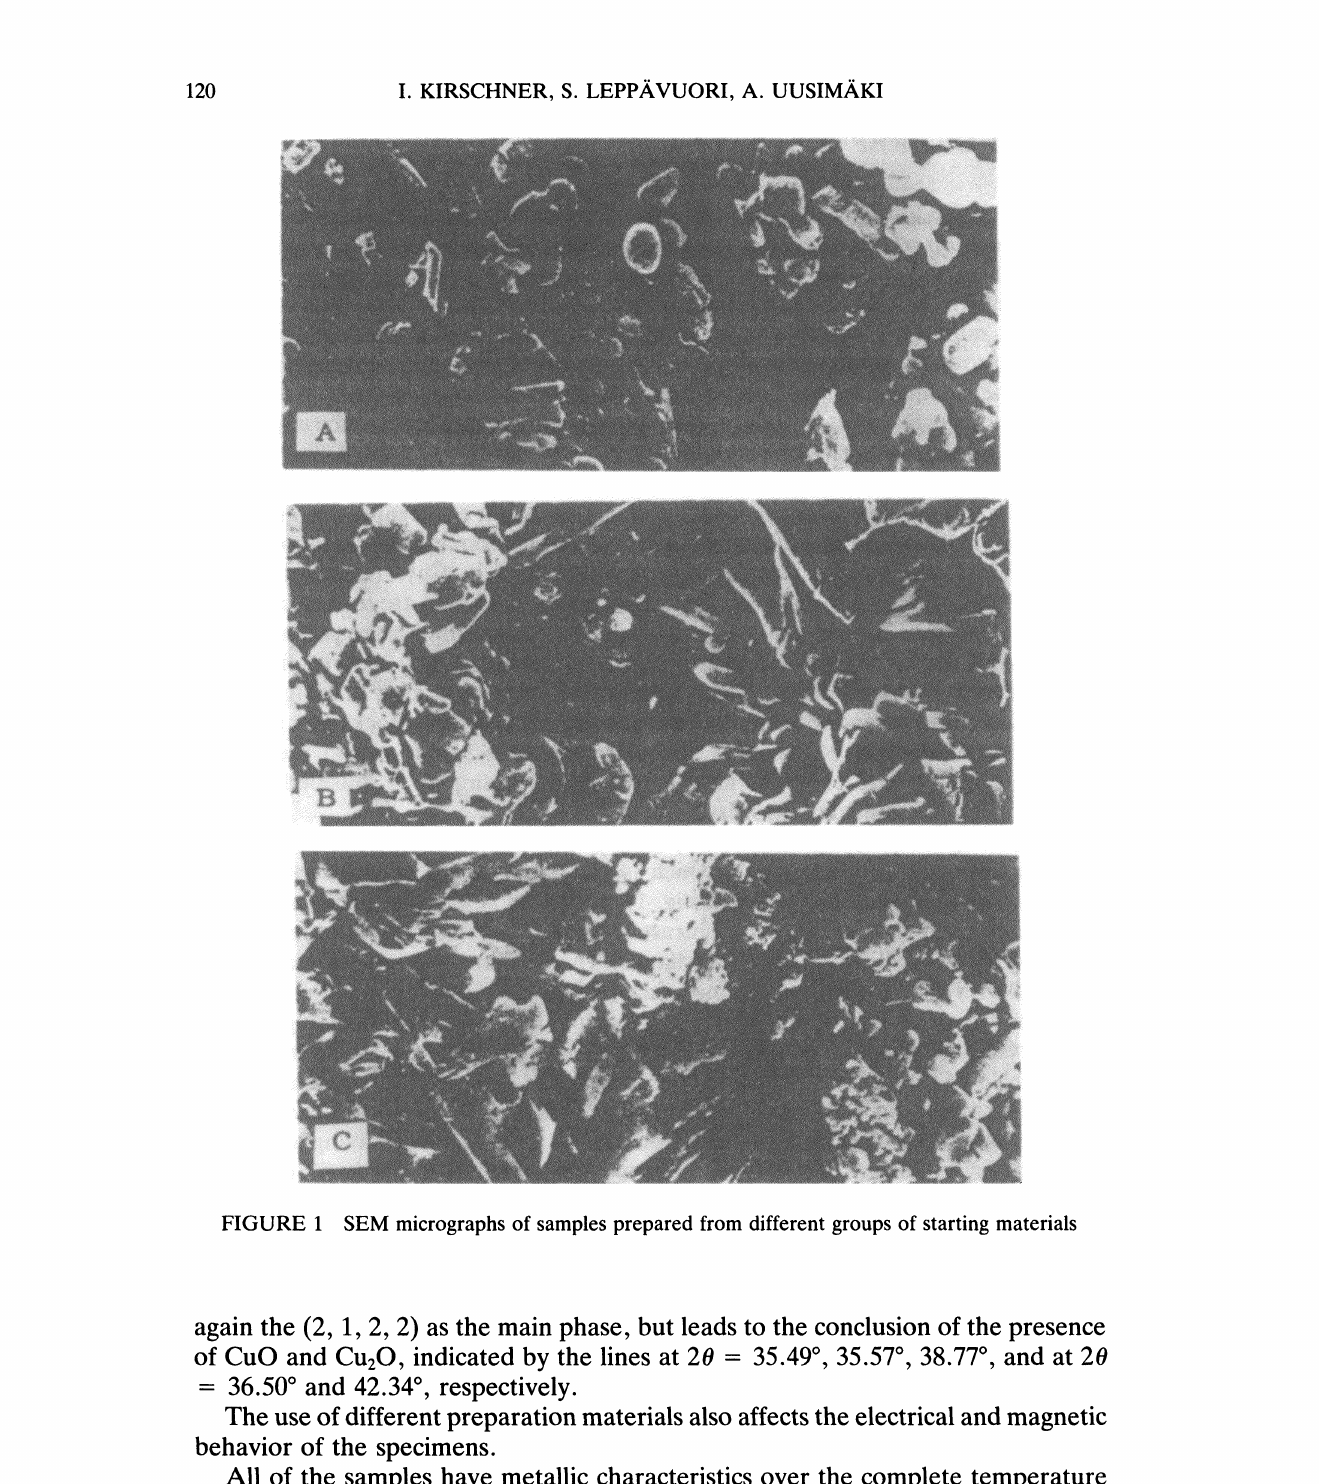
FIGURE SEM micrographs of samples prepared from different groups of starting materials again the (2, 1, 2, 2) as the main phase, but leads to the conclusion of the presence , of CuO and Cu20, indicated by the lines at 20 35.49 36.50 and 42.34